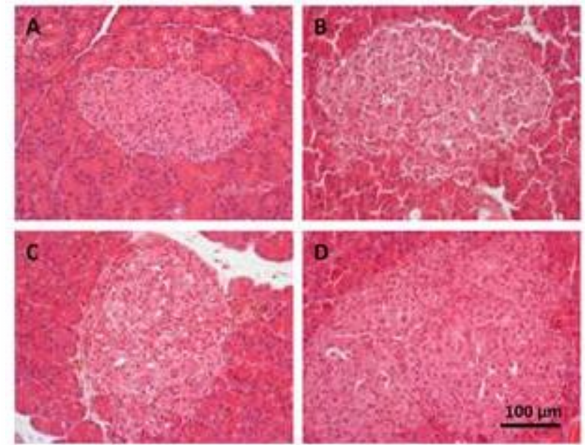
Figure 3. Optical microscope images (40 × ) of pancreatic sections stained with hematoxylin-eosin of 20-weeks old rats. ( A ) control Zucker lean rats (ZLR); ( B ) control Zucker fatty rats (ZFR); ( C ) ZFR treated for 12 weeks with 750 mg/kg/day of egg white hydrolyzed with pepsin; and ( D ) ZFR treated for 12 weeks with 750 mg/kg/day of egg white hydrolyzed with aminopeptidase. Bar: 100 µ m. Mean islet size of ZLR was 23.5 × 10 3 µ m 2 (see Figure 4). In contrast, all groups of obese ZFR rats